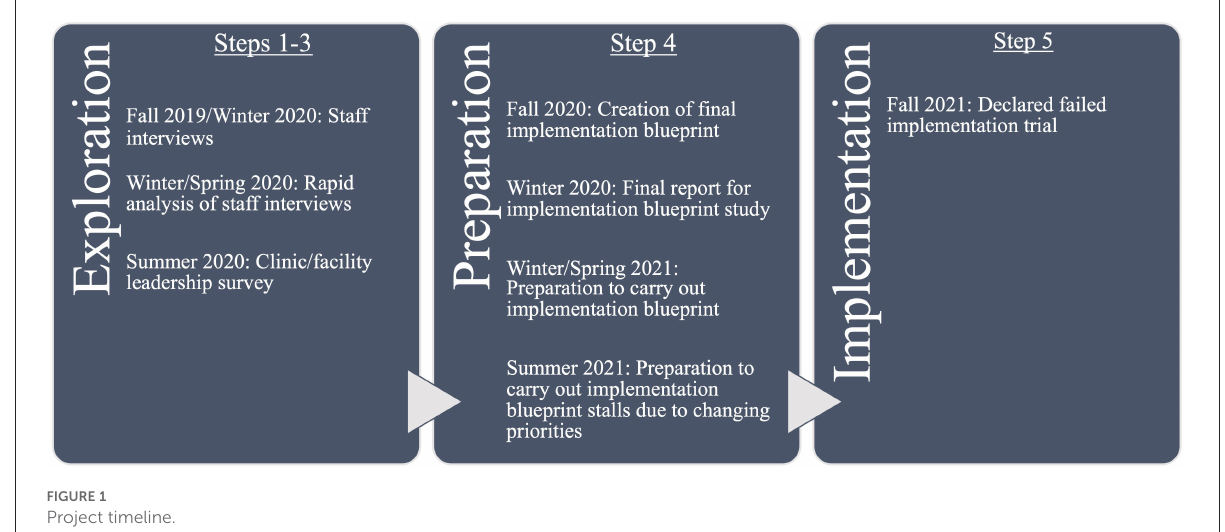
FIGURE1 Project